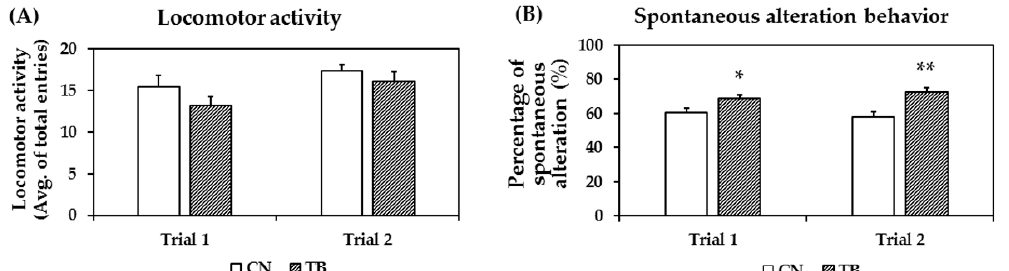
Figure 5. The effect of theobromine (TB) on locomotor activity and spontaneous alteration behavior in rats assessed by the Y-maze test. (A) Locomotor activity of TB-fed rats (TB rats) and control rats (CN rats). There were no significant differences between groups in both trials. (B) TB rats had a significantly higher number of alteration in both trials compared to CN rats. Values are the mean ± S.E.M. ( n = 8 for each group). * p < 0.05, ** p < 0.01; significant difference between groups.